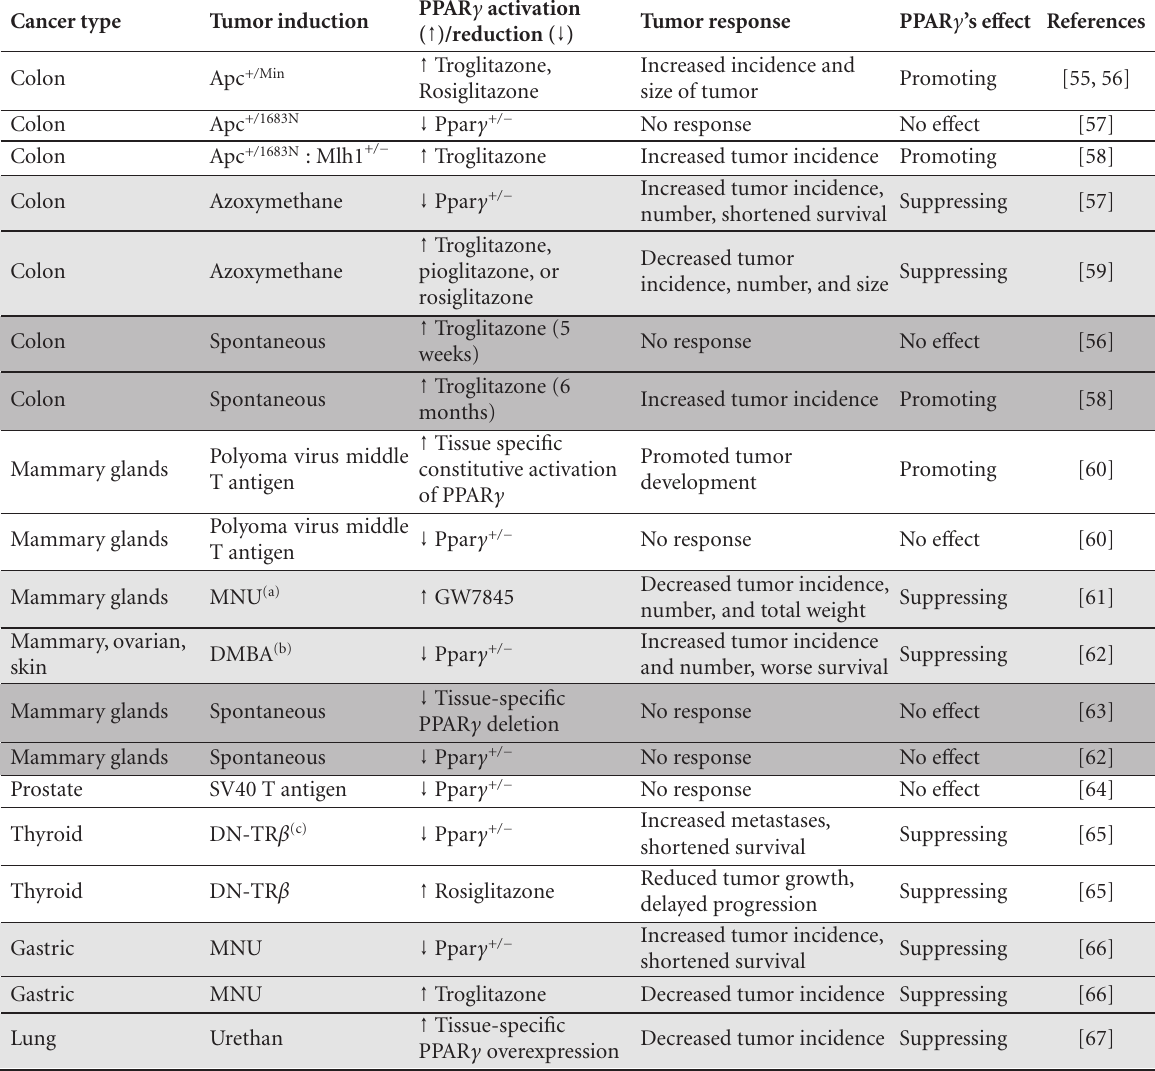
Un-shaded: Genetic tumor models Light grey-shaded: Carcinogen-induced tumor models Dark grey-shaded: Spontaneous tumor